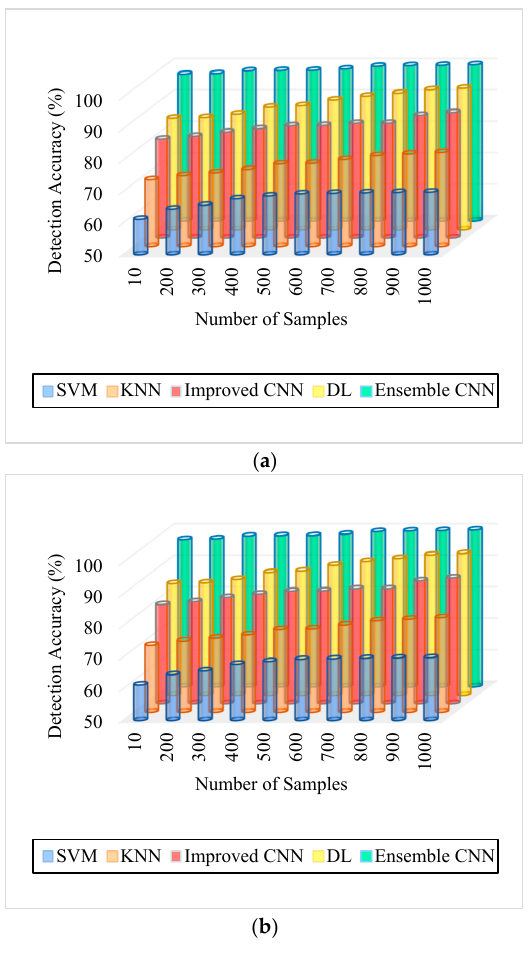
Figure 5. Detection accuracy ( a ). IDRiR and ( b ). Messidor.